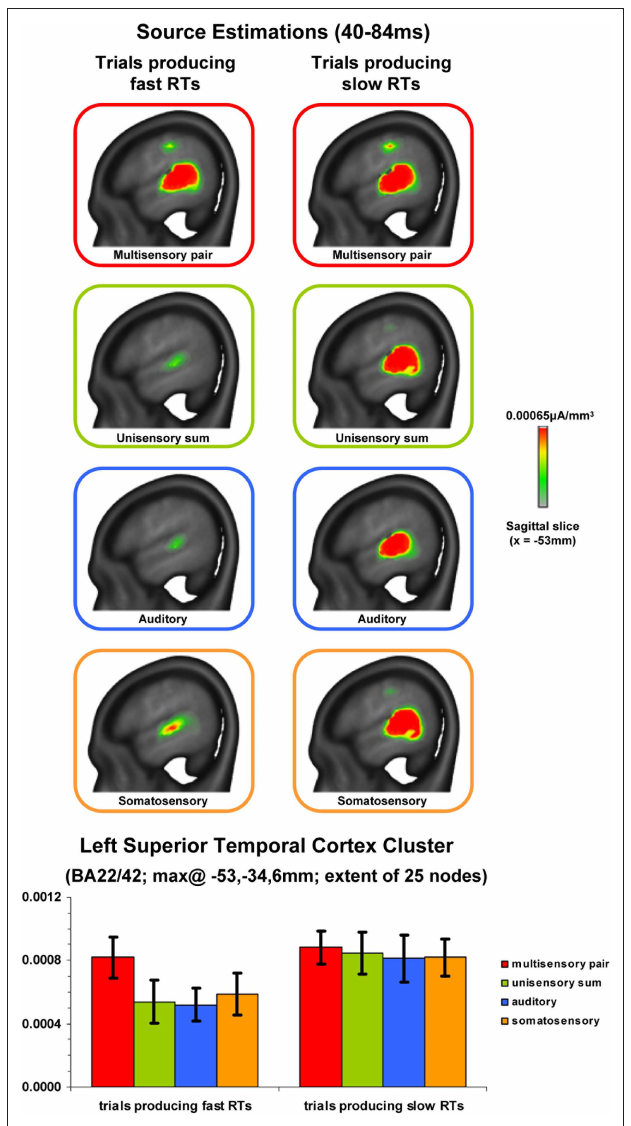
FIGURE 4 | Source estimations and statistical contrasts. The upper panels depict the mean source estimations over the 40–84 ms post-stimulus interval for each condition and subsequent RT speed at the sagittal slice of maximal amplitude ( x = − 53 mm using the Talairach and Tournoux (1988) coordinate system). The lower panels depict the mean (SEM shown) scalar values across nodes within the superior temporal cluster identifi ed across